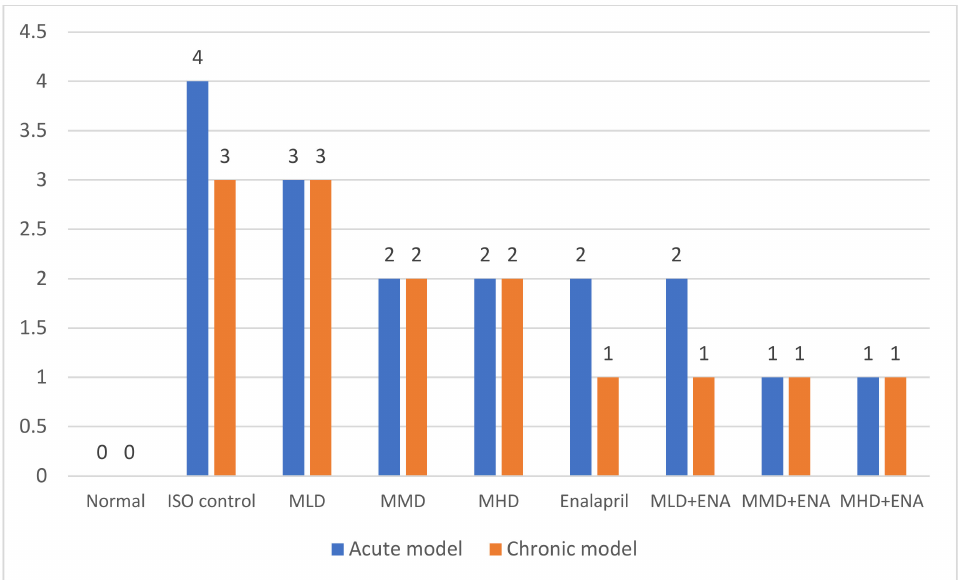
Figure 2. Histological scores in acute and chronic models of ISO-induced myocardial damage. Histopathological scores: 0 = normal cardiac muscle architecture; 1 = mild focal necrosis or degenera- tion; 2 = mild diffuse or moderate necrosis +/ − mild inflammation; 3 = moderate diffuse necrosis +/ − mild inflammation and fibrosis; and 4 = severe necrosis +/ − inflammation +/ −